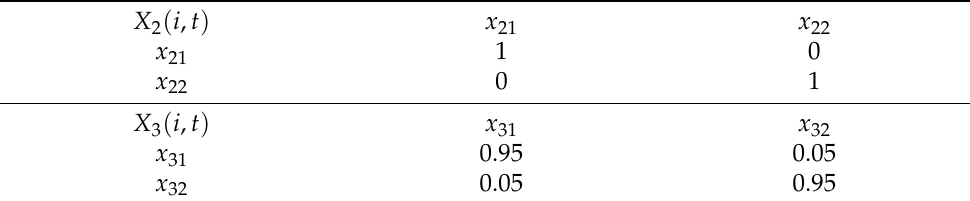
Table 7. CPDs of the target (on the left) and efficient countermeasures (on the right).